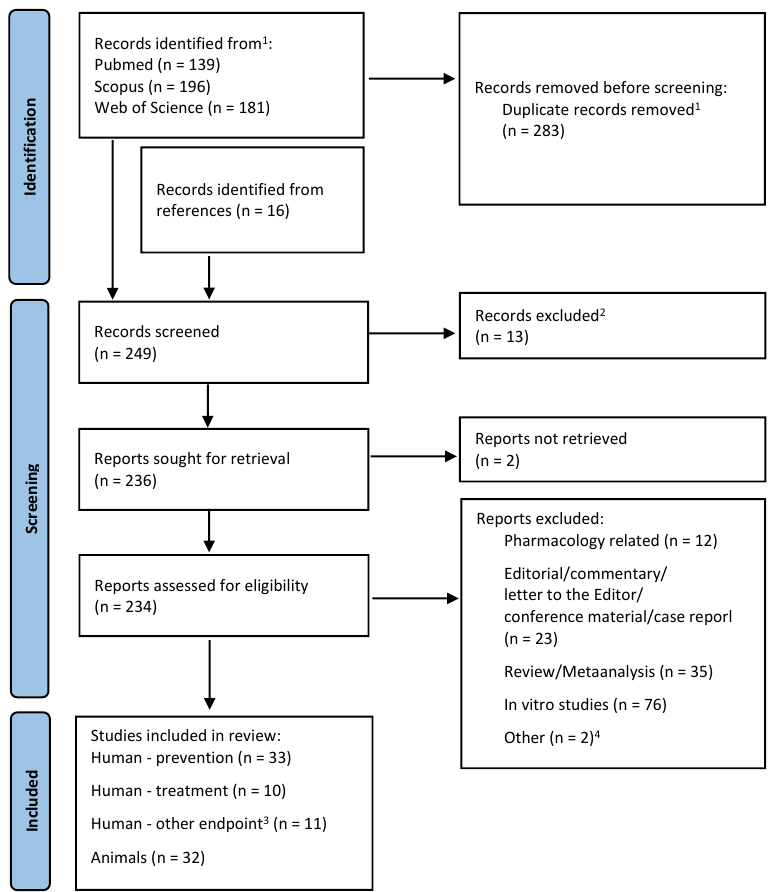
Figure 1. PRISMA flow diagram. 1 By automation tools based on PubMed ID (PMID). 2 Duplicates identified manually by title, DOI, or abstract. 3 Endpoint not related to cancer incidence, growth, or mortality. 4 One included preliminary results of the study that had been already included in the review and the second was an epidemiological study.